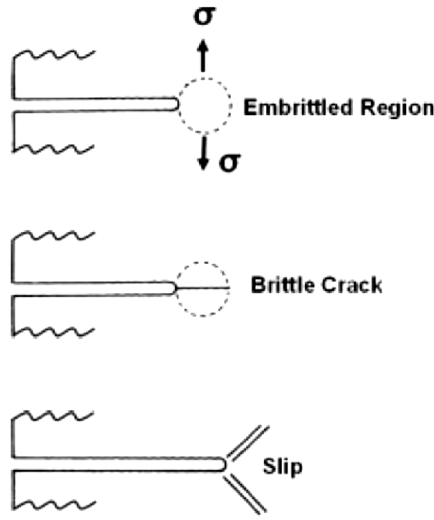
Figure 7. Model for mechanical induced cracking. Reproduced with permission from [75], John Wiley and Sons, 2005. and Sons,